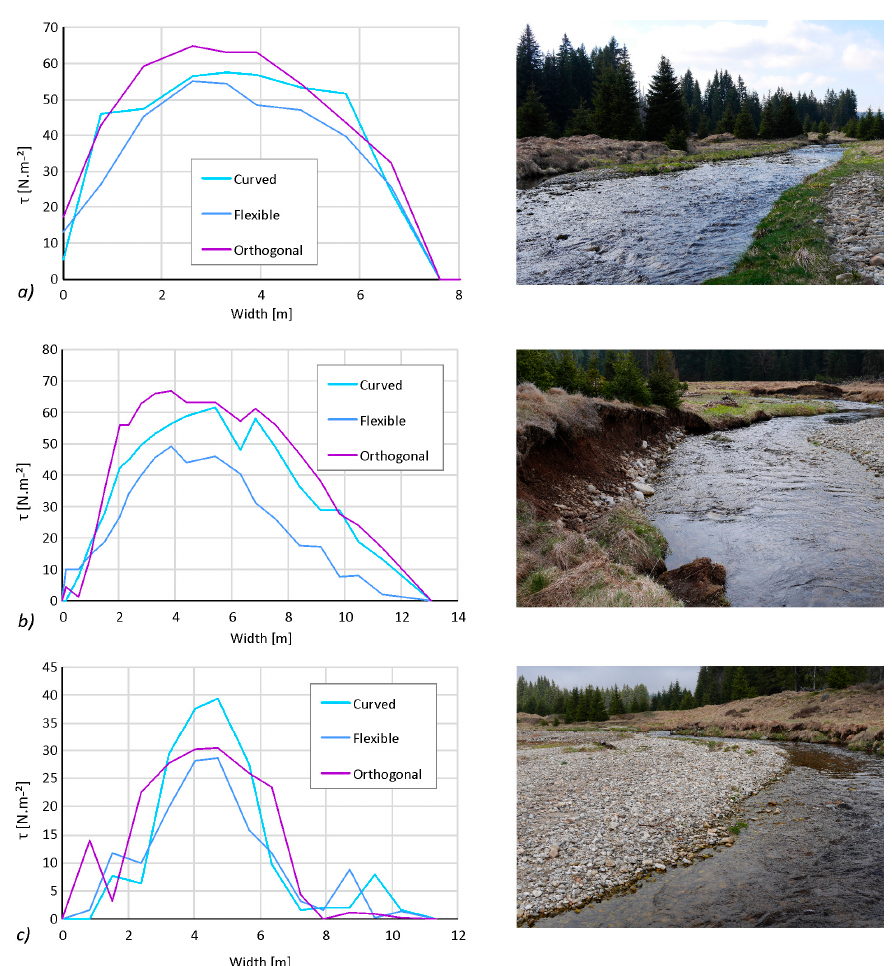
Figure 14. Distribution of depth-averaged shear stress at typical cross-sections. ( a ) Straight reach; ( b ) bank failure; ( c ) fresh accumulation.